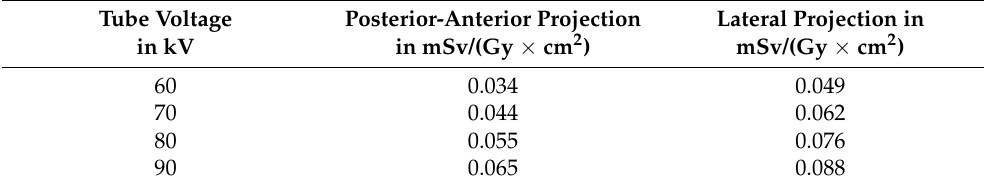
Lateral Projection in mSv/(Gy × cm 2 )